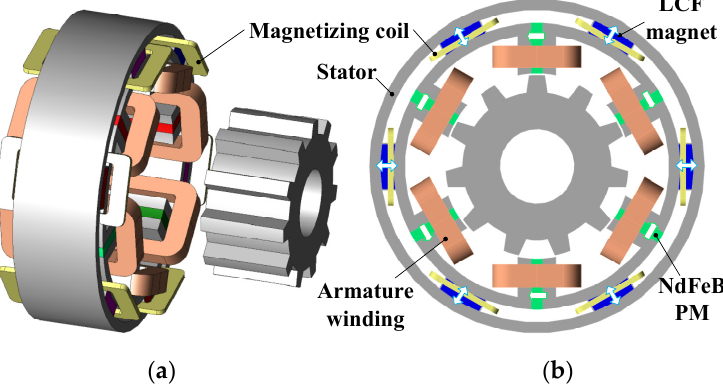
Figure 1. Topology of the investigated SF-HMMM. ( a ) 3D exploded view. ( b ) Cross-sectional view.